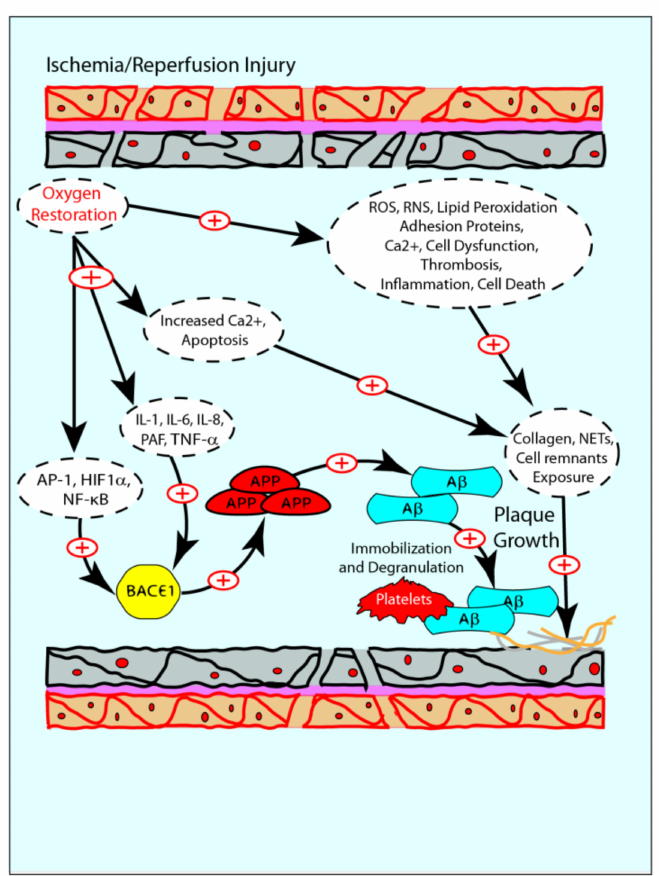
Figure 4. Schematic representation of A β –IRI relation. After reperfusion inflammation, pO 2 changes and endothelial cell dysfunction create optimal conditions for A β to re-initiate the atherosclerotic plaques. Because of A β ’s cytotoxic and pro-inflammatory e ff ects, it could be hypothesized that it is involved in IRI as